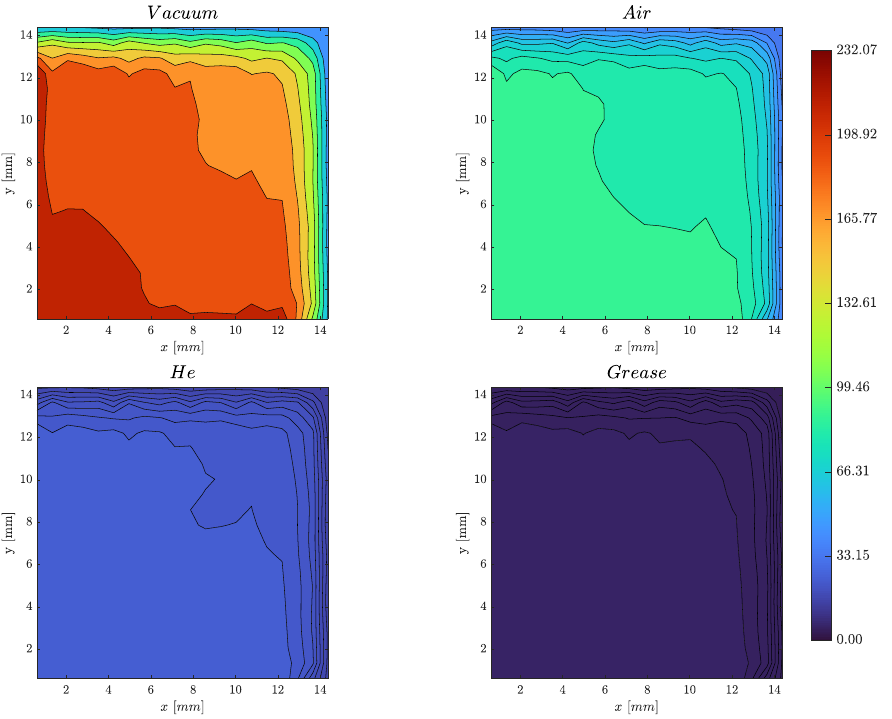
Figure A6. Complete thermal contact resistance ( R TC [ ◦ Cmm 2 /W]) comparison at the potential contact